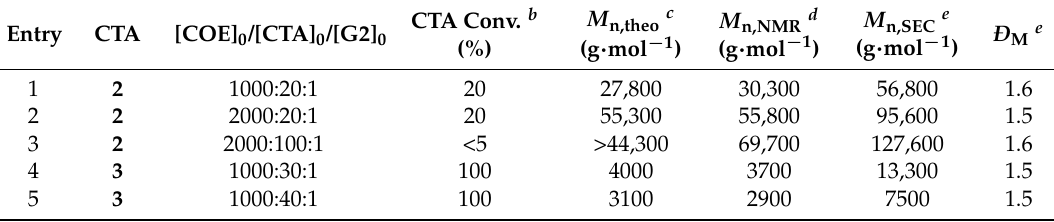
Table 1. ROMP/CM of COE catalyzed by G2 in the presence of oxetane CTAs 2 and 3 in CH 2 Cl 2 at 40 ◦ C over 24 h (Scheme 1) a